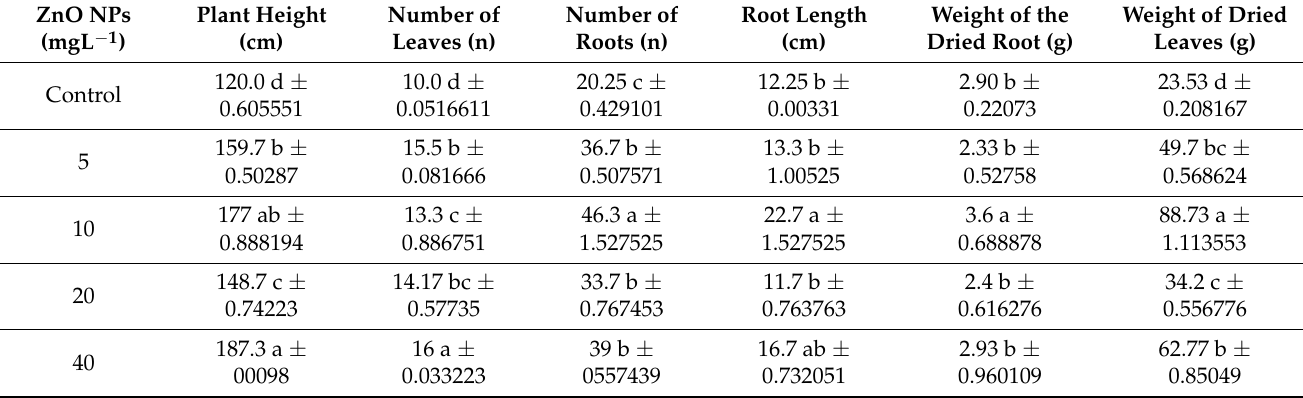
Table 1. Zinc oxide nanoparticles (ZnO NPs) impact the plant height (cm), number (n) of leaves and roots, and dried weight (g) of leaves and roots of C. longa. Mean values followed by the same letter within a column are not significantly different at p = 0.05, as measured by Duncan’s